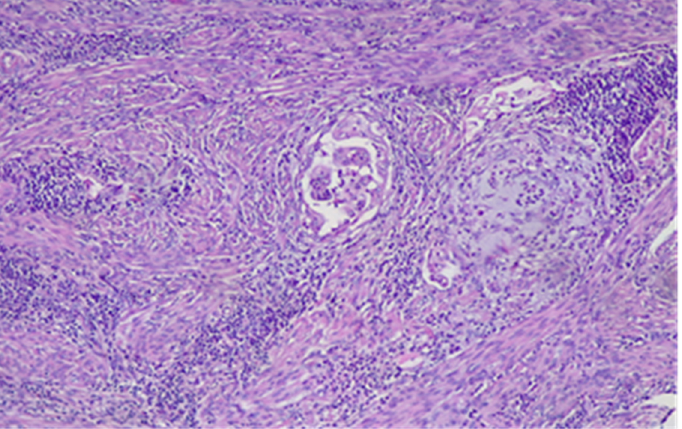
Figure 3. MELF pattern of MI. HE × 10.